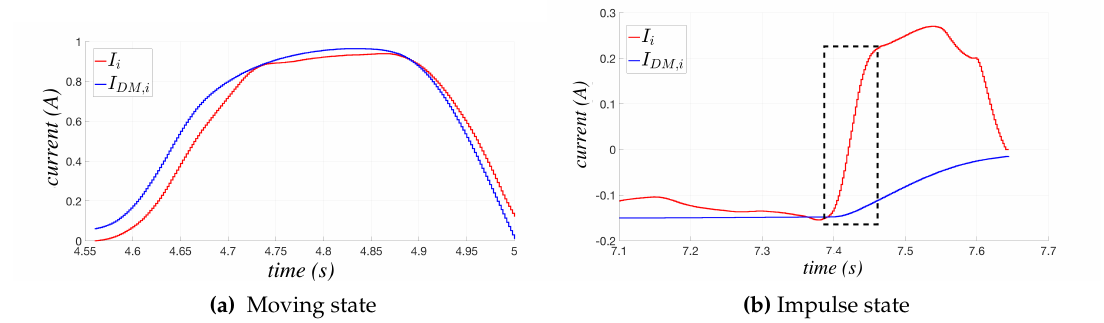
Figure 7. Examples of the behavior of I i ( t ) and I DM , i ( t ) during the moving and the impulse